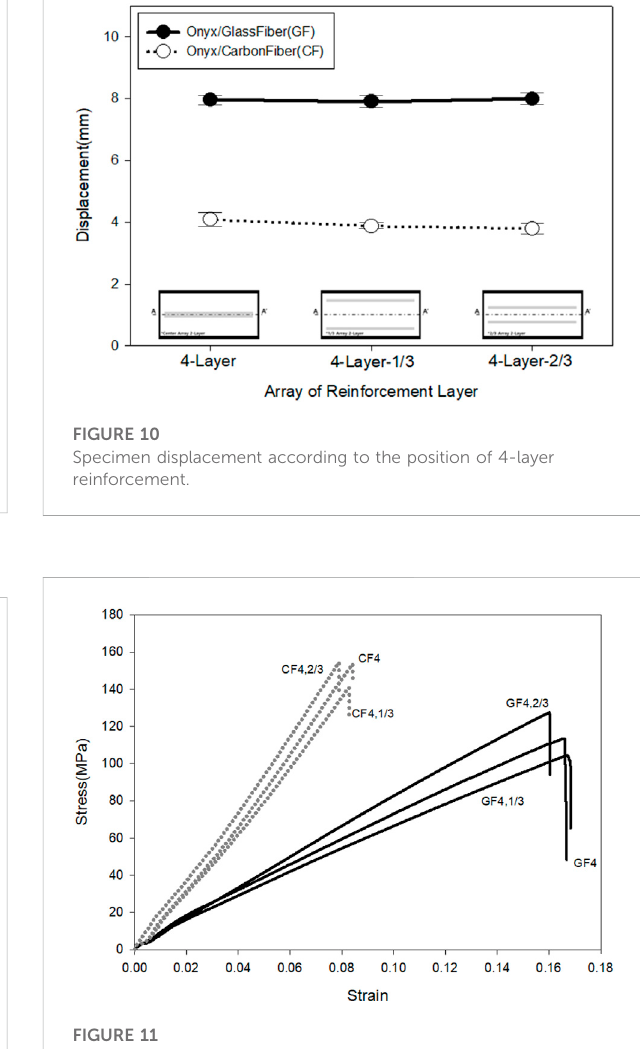
FIGURE 9 Tensile force according to the position of 4-layer reinforcement.